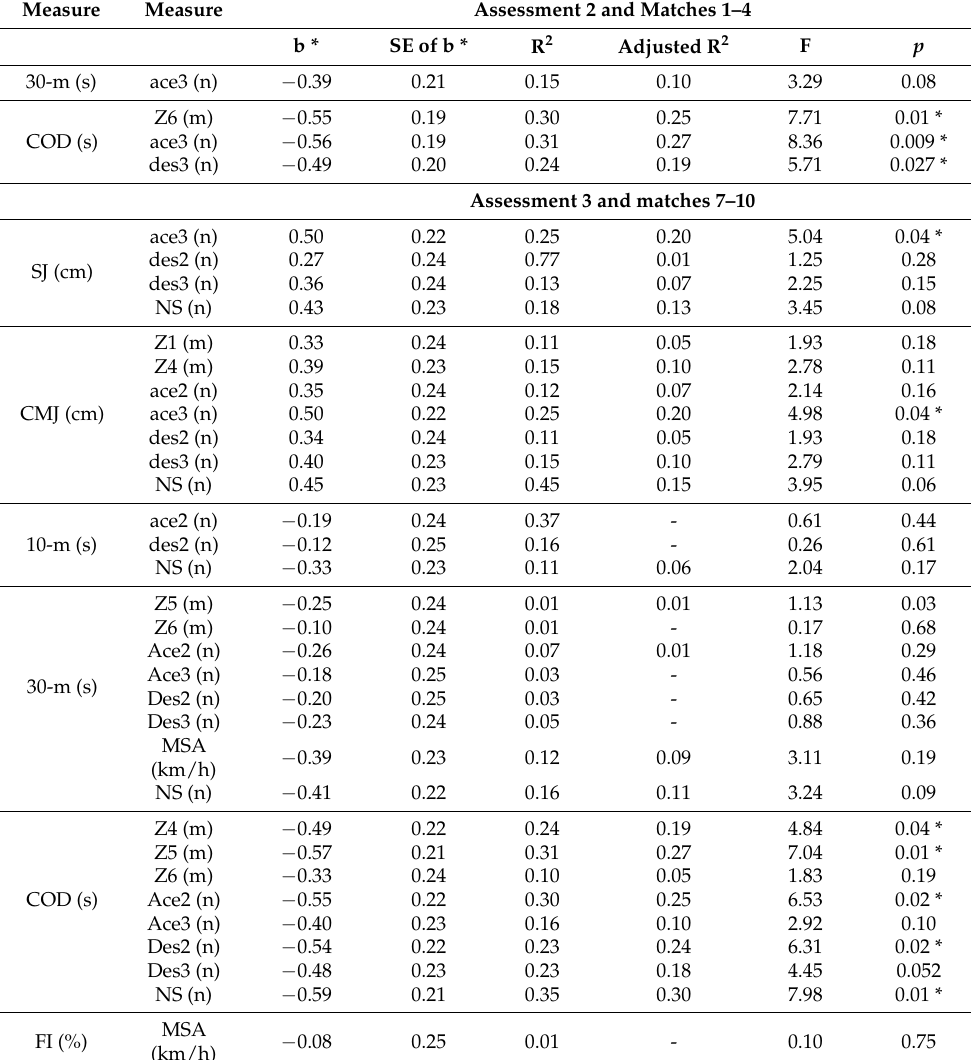
Table 5. Values of regression analysis explaining fitness assessment and match running